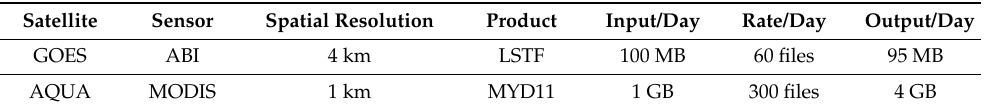
Table 1. LST Satellites Data Sources.